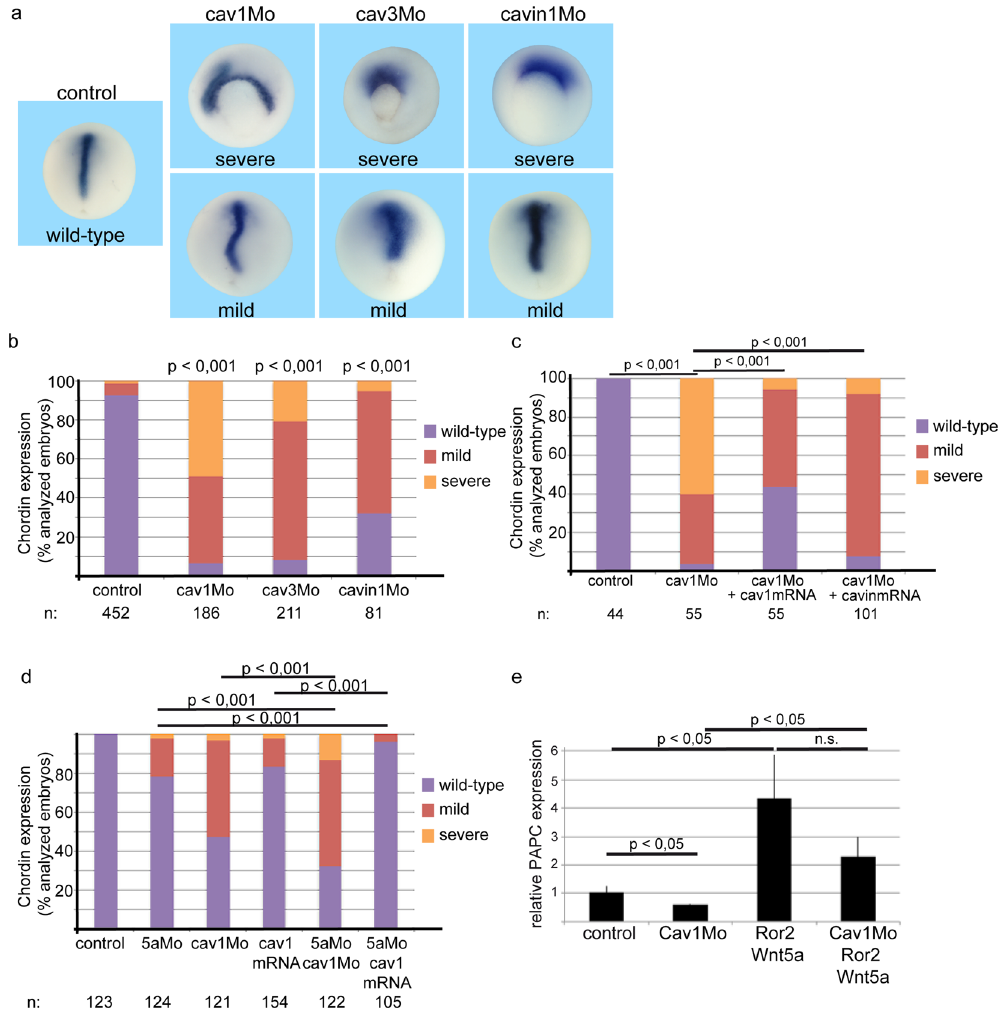
Figure 2. The caveolar core components caveolin1, caveolin3 and cavin1 are necessary for convergent extension movements. Antisense morpholino oligonucleotides directed against caveolin1 (cav1Mo), caveolin3 (cav3Mo) and cavin1 (cavin1Mo) were injected in the marginal zone of both dorsal blastomeres of 4-cell stage embryos. Embryos were fixed at stage 14 and analyzed for localization of the axial mesodermal marker gene chordin . ( a ) In control embryos, chordin is expressed in a long and narrow strip along the dorsal midline. Depletion of caveolar proteins resulted in mislocalization of chordin expression. In severe cases, chordin expression remained at the dorsal part of the unclosed blastopore. The phenotype was classified as mild when the chordin expression was bent or short and broad. ( b ) Quantification of the phenotypes in the morphants resulting from the injection of 4 pmol cav1Mo, 4 pmol cav3Mo and 0.4 pmol cavin1Mo, respectively. ( c ) Caveolin1 and cavin1 patially restore chordin expression in cav1 morphants. 4 pmol cav1Mo were coinjected with 500 pg caveolin1 and cavin1 mRNA, respectively. ( d ) Epistasis experiments with Wnt5a morpholino (5aMo, 0.4 pmol), caveolin1 morpholino (cav1Mo, 0.25 pmol) and caveolin1 mRNA (500 pg) revealed additive effects of the morpholinos. Furthermore, caveolin1 mRNA partially restored gastrulation in Wnt5a morphants. P values according to a χ 2 test, n: number of embryos. ( e ) Realtime PCR of animal cap explants revealed that the expression of the Wnt5a target gene PAPC depends on caveolin1 expression. Shown are the mean values, standard errors and p values according to Student’s t-test of four independent